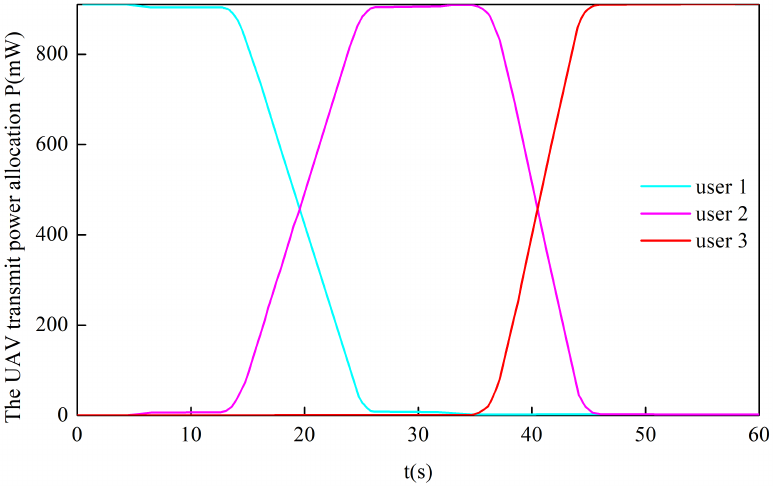
Figure 9. The relationship between UAV power allocation and